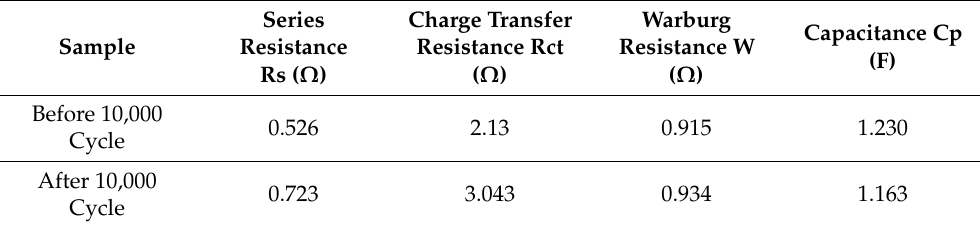
Table 2. Estimated impedance parameters from the Nyquist plot of sample